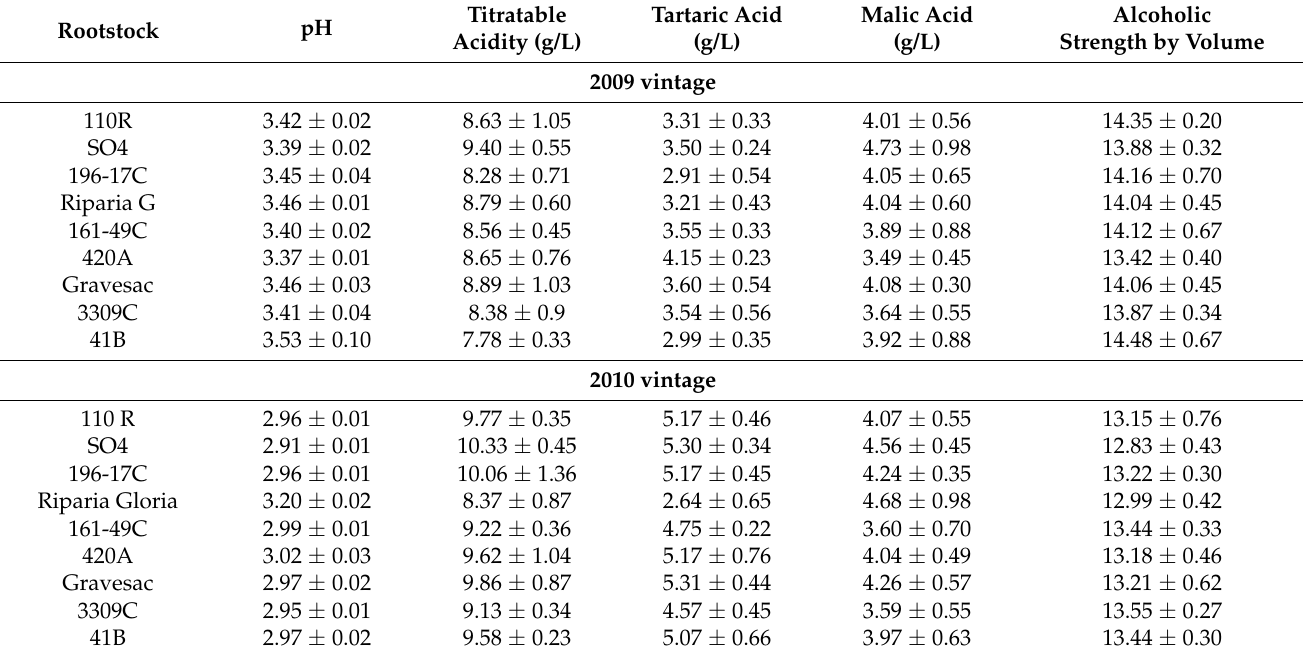
Table 3. Chemical composition of Albariño wines from different rootstock, over two